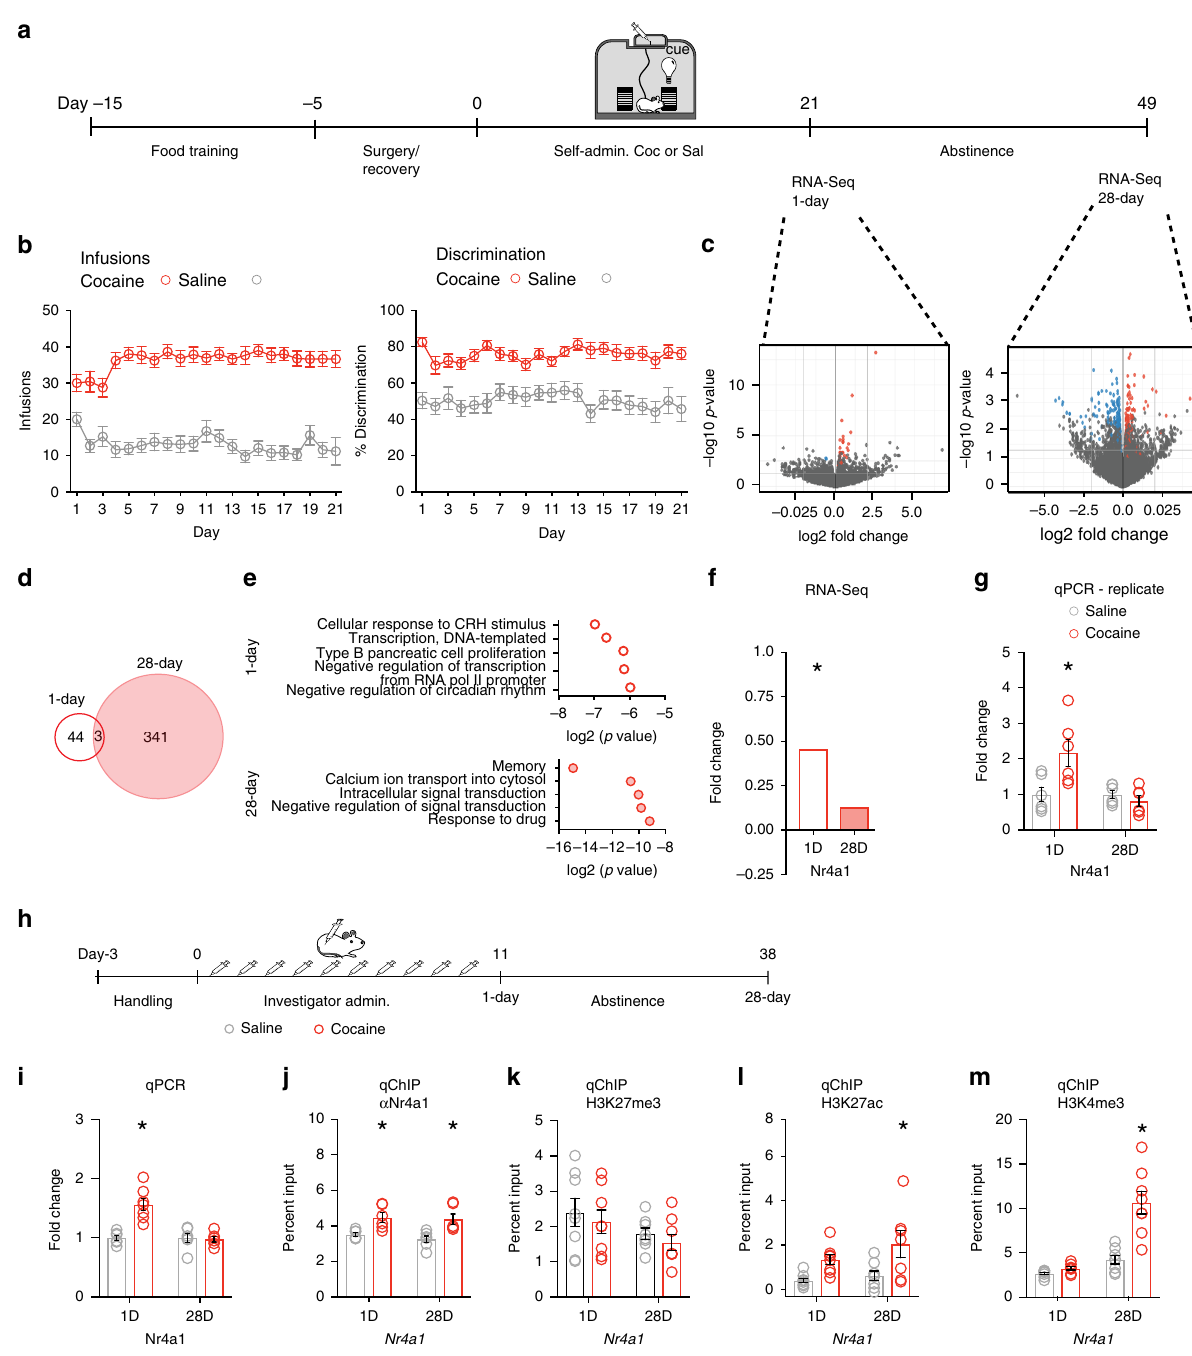
DNA-templatedCellular response to CRH proliferationTranscription, promoterType B pancreatic cell regulation of transcription from RNA pol II